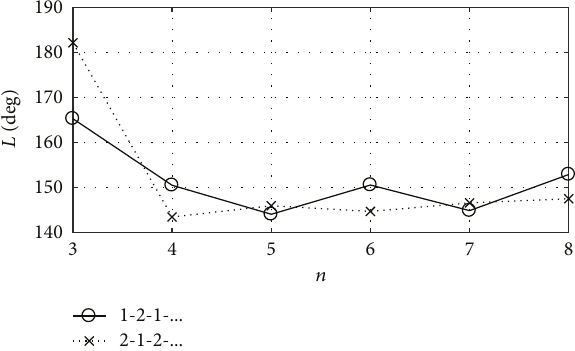
Figure 4: Path lengths according to the number of maneuvers for case 2.